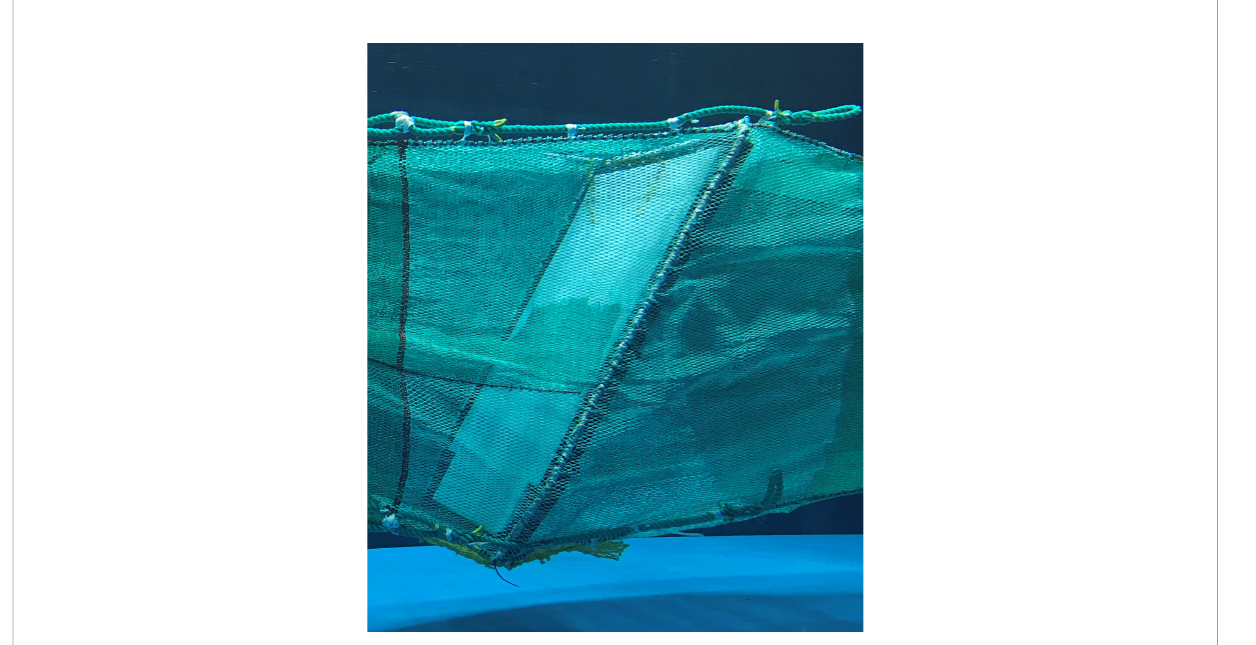
FIGURE 1 Close-up view of the 19-mm Nordmøre grid system used in the